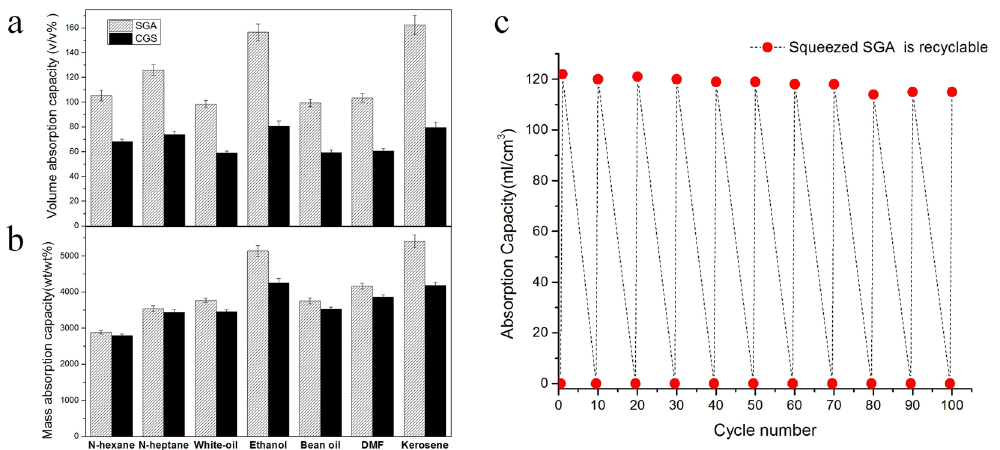
Figure 4. Comparison of the absorption capacities of different organic liquids (kerosene, DMF, bean oil, Ethanol, White-oil, N-heptane and N-hexane) on a ( a ) mass basis and ( b ) volume basis ( b ), error bars show the standard deviations on triplicate measurements. ( c ) The high absorption recyclability of SGA with N-heptane; The inset image shows the spontaneous absorption performance of SGA, in which N-heptane was stained with Sudan Red 3 and floated on deionized